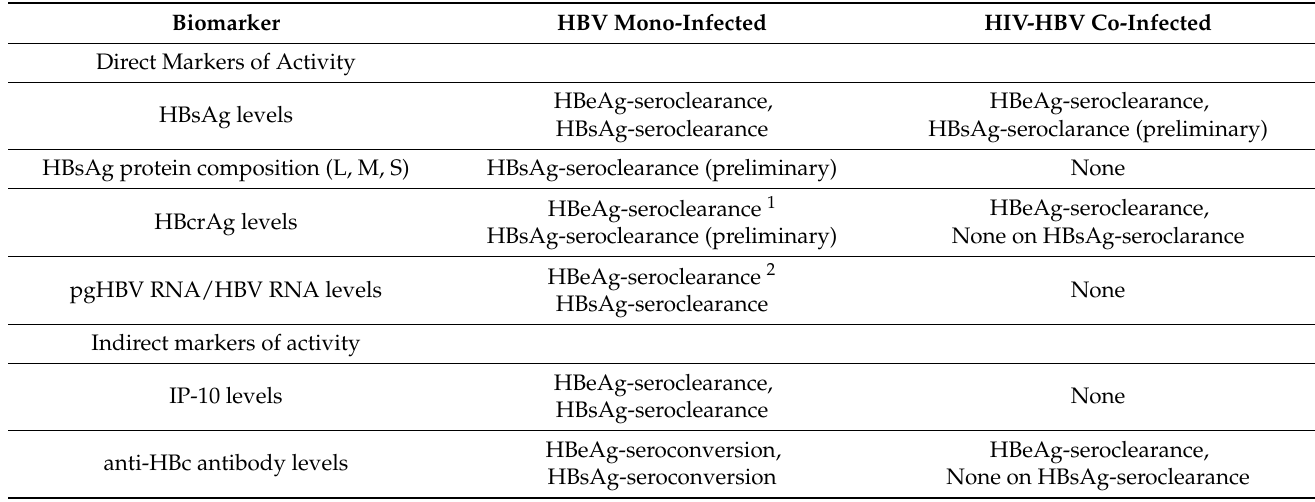
Table 3. Serological endpoints evaluated with novel biomarkers in hepatitis B virus mono-infected and human immunodefi- ciency virus-hepatitis B virus co-infected